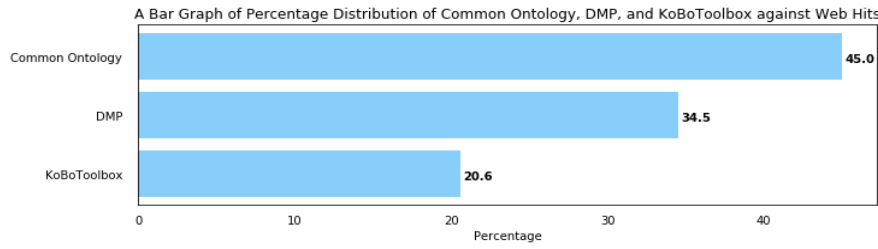
Figure 13. New and returning users on the various software components.